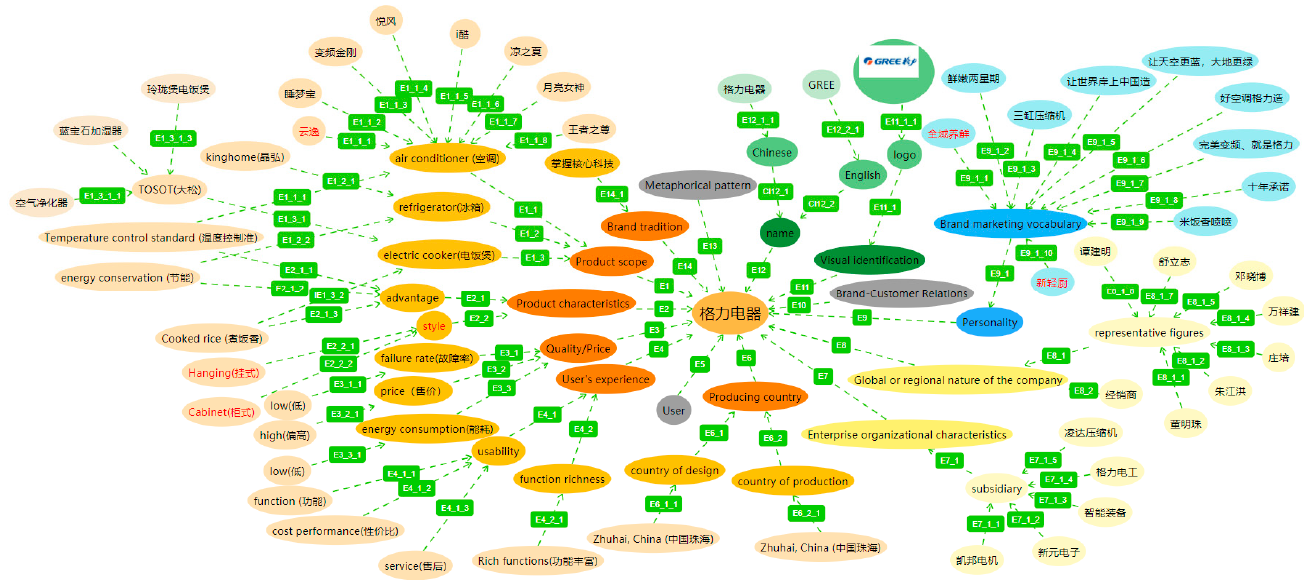
Figure 8. the BI KG of GREE Electric on 30 November 2022. Figure 8. The BI KG of GREE Electric on 30 November 2022.